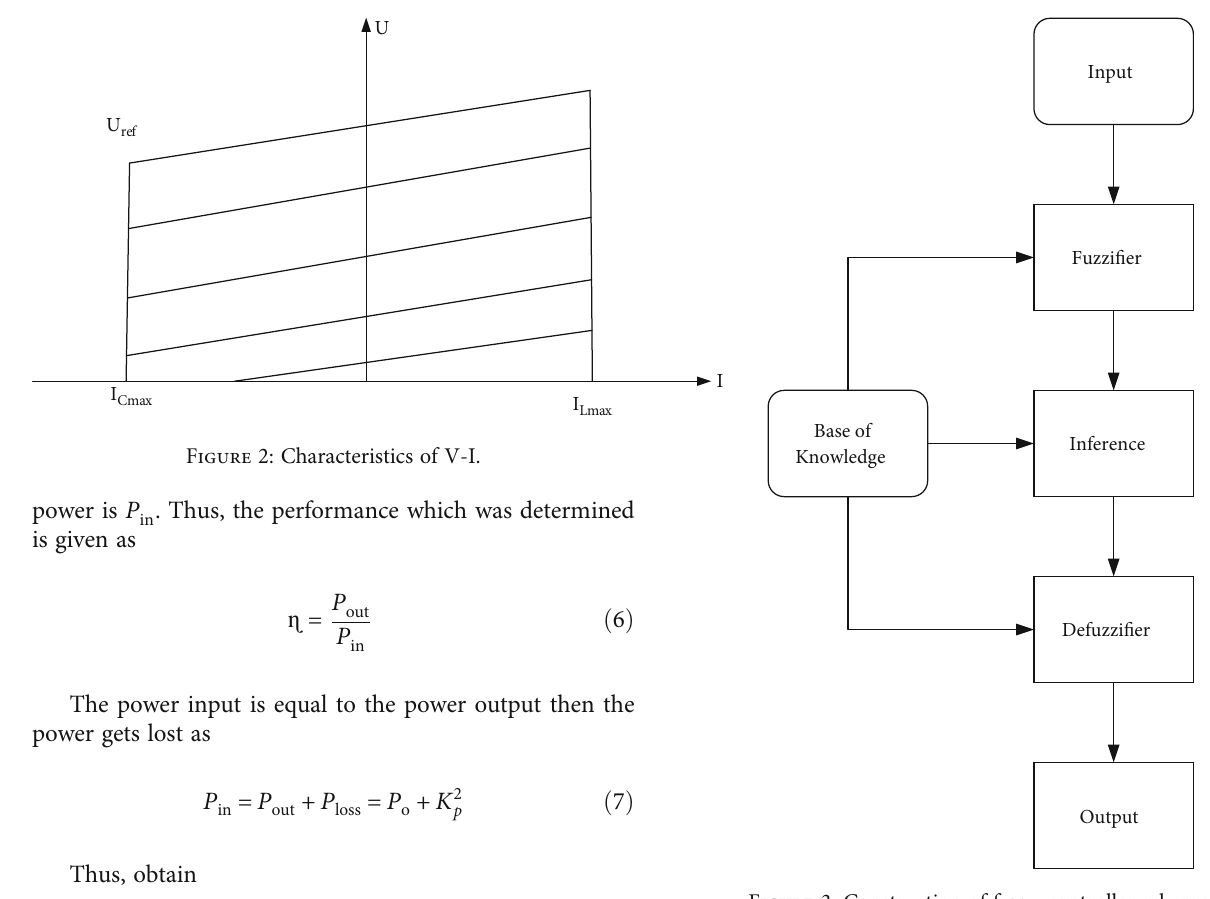
Figure 3: Construction of fuzzy controller